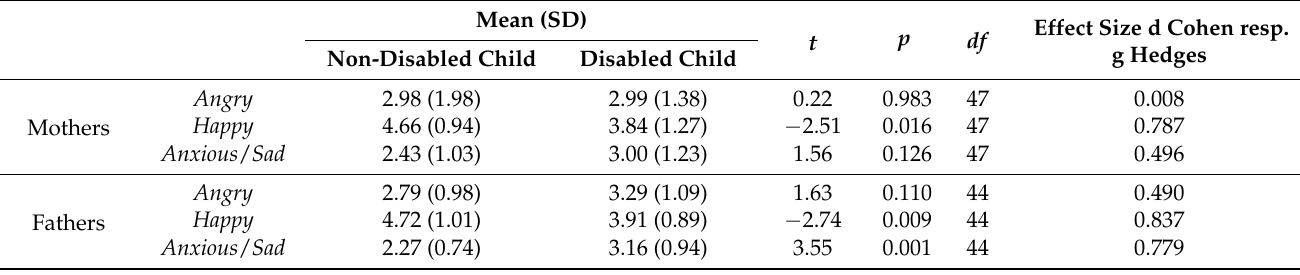
Mean (SD) Effect Size d Cohen resp.